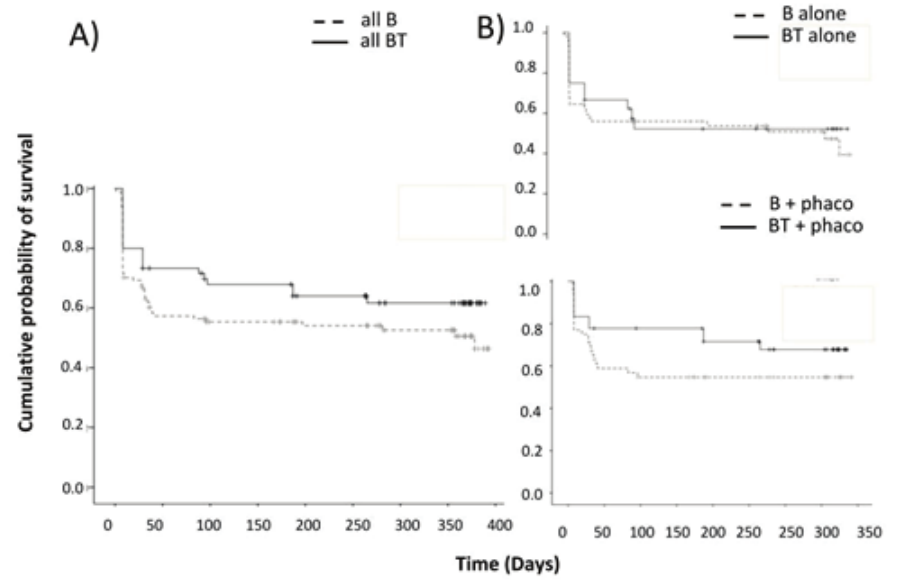
Figure 1. (A) Kaplan–Meier survival plots for the BT and B groups with success defined as a final IOP of ≤ 21 mmHg and a 20% reduction from baseline. Success rates of BT and B was similar in both groups. (B) survival plots of the BT and B for subgroup analysis separated by (B) glaucoma surgery alone and (C) same-session phacoemulsification (lower right).